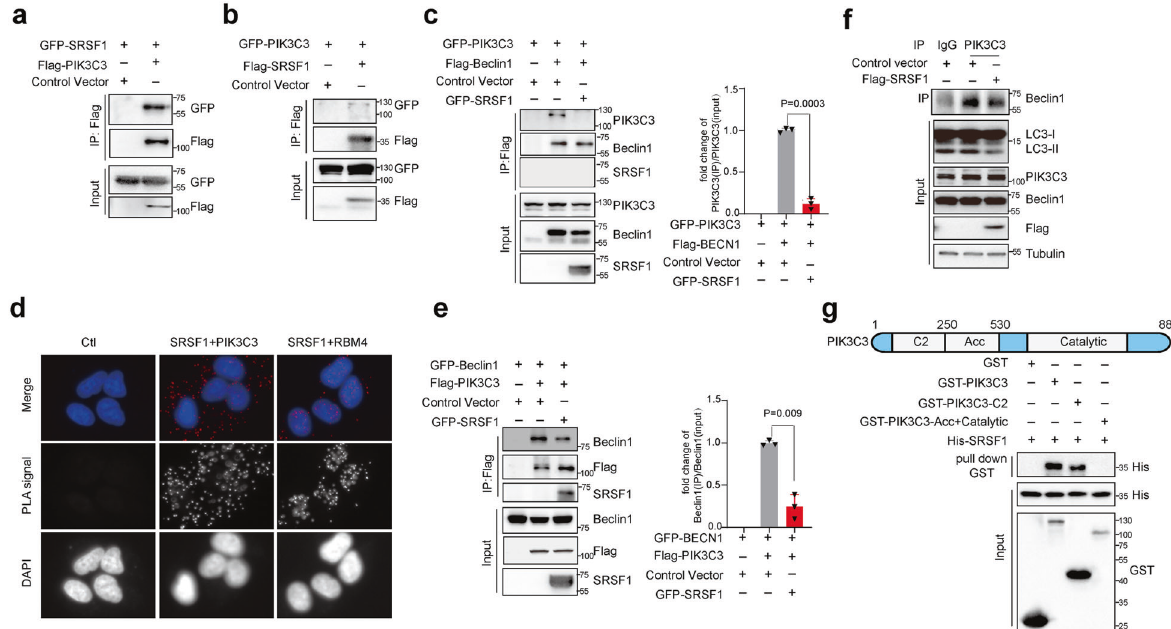
Fig. 5 SRSF1 interacts with PIK3C3 to disrupt the Beclin-PIK3C3 complex and suppresses autophagy. 293 T cells were co-transfected with different combinations of Beclin1, PIK3C3, and SRSF1 expression vectors in a – c and e . a 293 T cells were co-transfected with pEGFP-C1-SRSF1 and control vector; or pEGFP-C1-SRSF1 and Flag-PIK3C3 expression vector. b 293 T cells were co-transfected with pEGFP-C1-PIK3C3 and control vector; or pEGFP-C1-PIK3C3 and Flag-SRSF1 expression vector. c 293 T cells were co-transfected with pEGFP-C1-PIK3C3 and control vector; or pEGFP-C1-PIK3C3 and Flag-Beclin1 expression vector; or pEGFP-C1-PIK3C3, Flag-Beclin1, and GFP-SRSF1 expression vectors. d Proximity ligation assay (PLA) was performed to examine the endogenous interaction between SRSF1 and PIK3C3 in A549 cells. The examination of the endogenous interaction between SRSF1 and RBM4 was assayed as a positive control. PLA signals were shown in red and the nuclei were demonstrated in blue. e 293 T cells were co-transfected with pEGFP-C1-Beclin1 and control vector; or pEGFP-C1-Beclin1, and Flag-PIK3C3 expression vector; or pEGFP-C1-Beclin1, Flag-PIK3C3 and GFP-SRSF1 expression vectors. Immunoprecipitation assay was performed with anti-Flag M2 beads and the precipitated complexes were analyzed by western blot with anti-Beclin1, anti-PIK3C3, or anti- SRSF1 antibodies in c , e . Three experiments were conducted and the mean ± SD of the relative ratio of the precipitated Beclin1 or PIK3C3 were analyzed and plotted in c , e . f H1299 cells with overexpression of SRSF1 were used for the immunoprecipitation experiments. Immunoprecipitation assay was performed with anti-PIK3C3 antibody and the precipitated complexes were measured by western blot assay with anti-Beclin1 antibody. The lysate was applied to examine the autophagy status. g GST pull-down assays to analyze direct binding of recombinant human GST-tagged PIK3C3, GST-tagged PIK3C3 C2 domain, GST-tagged PIK3C3 Acc Catalytic domain and His-tagged SRSF1. The p values were calculated by t-test in panels c ,